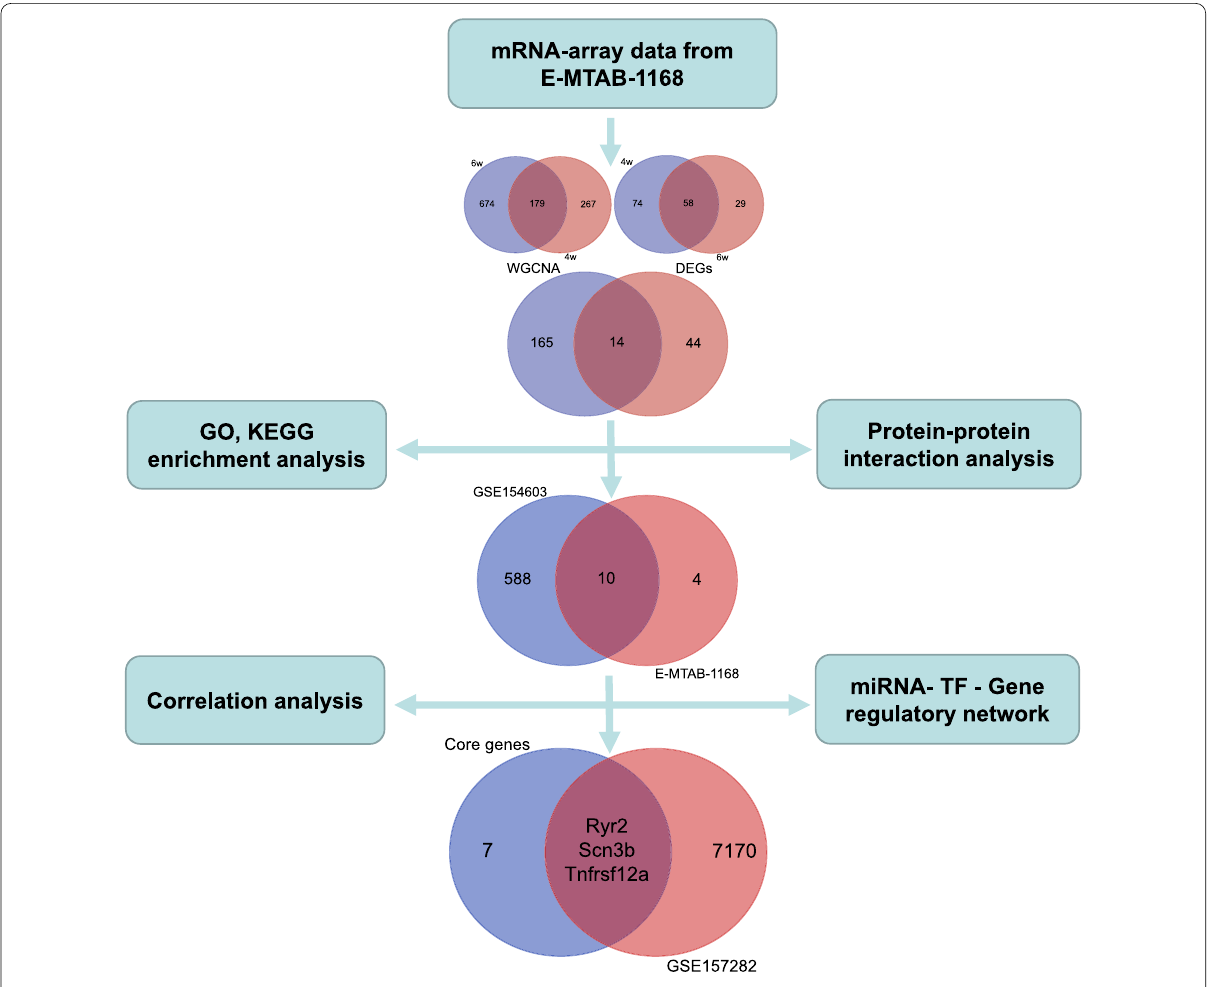
Fig. 1 Flow diagram of the analysis